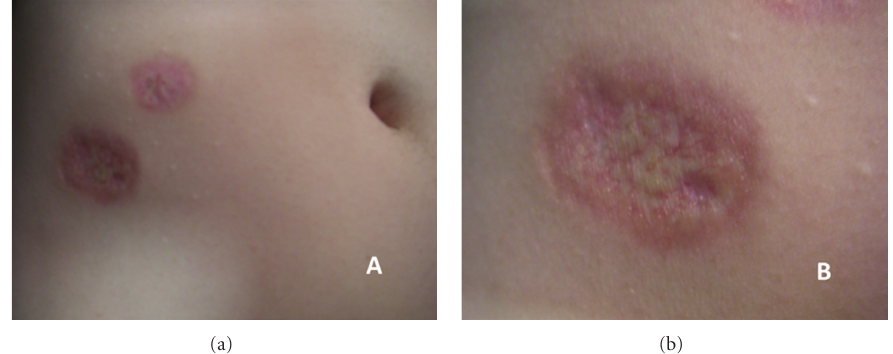
Figure 1: Yellow-brown, atrophic plaques surrounded by raised, violaceus rims on the right side of the lower abdomen (a); particular of the skin lesions (b).